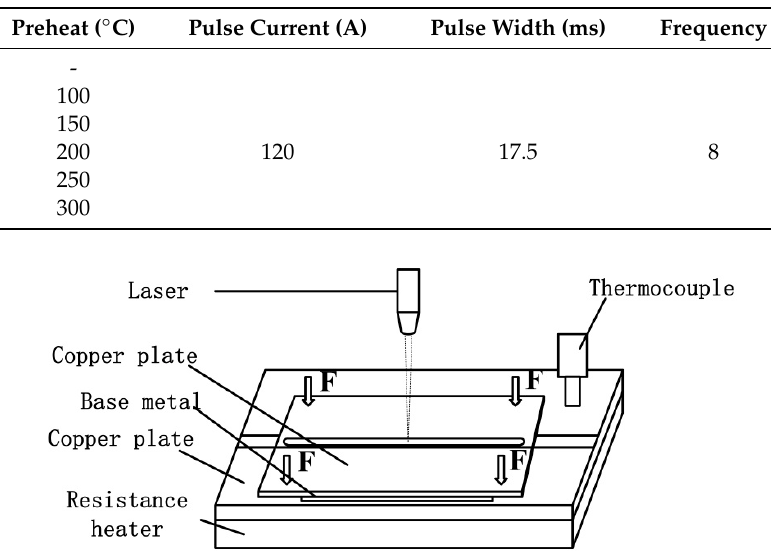
Table 3. The parameters of laser welding.